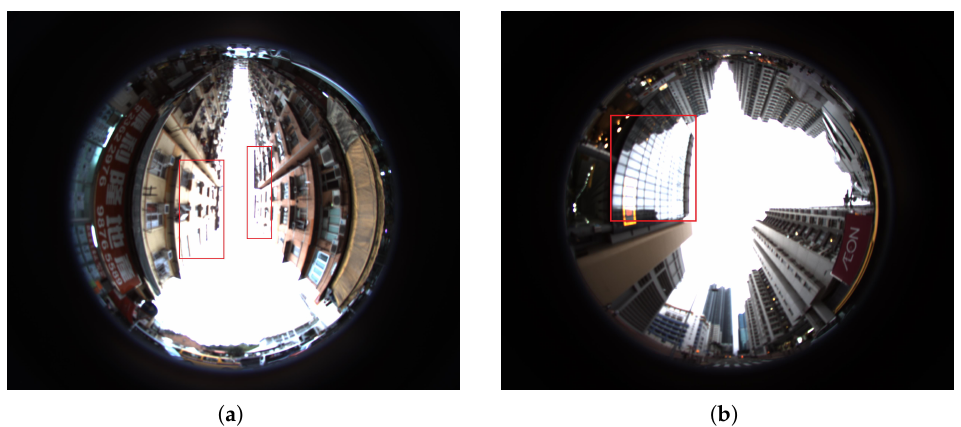
Figure 1. Two examples of reflections on the surfaces of tall buildings. ( a ) There are a large number of bright areas on the surfaces of buildings with colors similar to the sky. ( b ) Reflective windows are present on the surfaces of